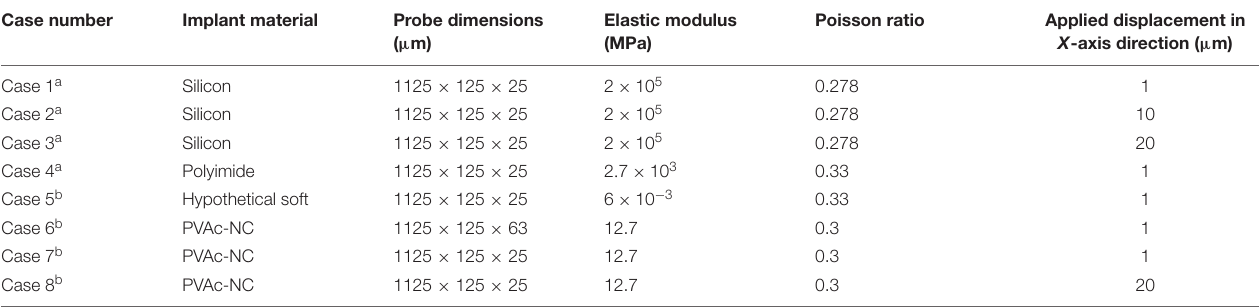
TABLE 1 | The material properties, dimensions, and boundary conditions for each modeled probe and simulation